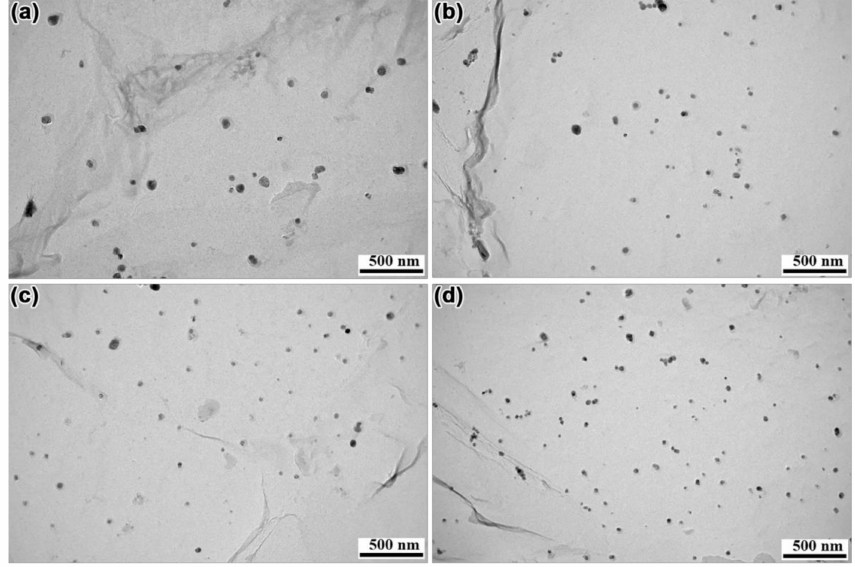
Figure 11. The precipitates in the four kinds of steel, ( a ) N1, ( b ) N2, ( c ) N3, and ( d ) N4 steel.